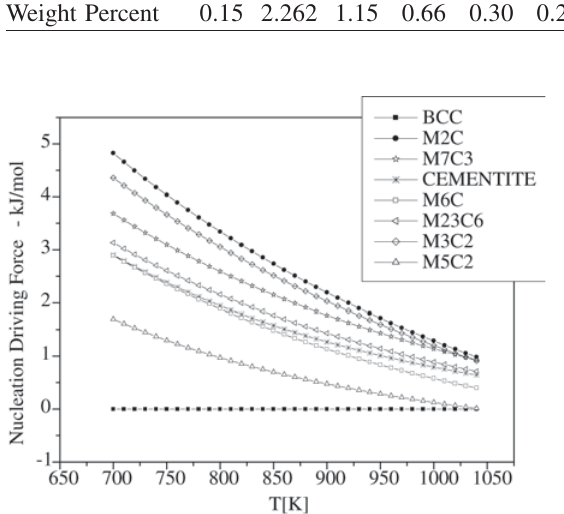
Figure 3. Driving Forces for Nucleation of carbides in a 2.25Cr- 1.0Mo